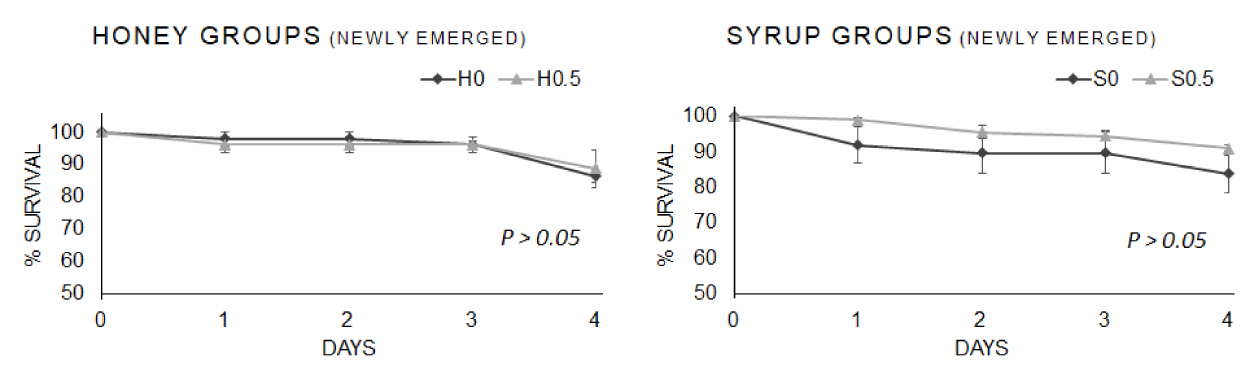
Figure 1. Survival rate of newly emerged bees fed syrup or honey base-diets, supplemented with β -glucans (0.5% w / w ), and control groups. Each curve indicates the sum of three replicates per group. The bars indicate the standard error calculated on the survival of the three replicates per each group. H = honey; S = syrup; 0, 0.5 = % ( w / w ) 1,3-1,6 β -glucans.